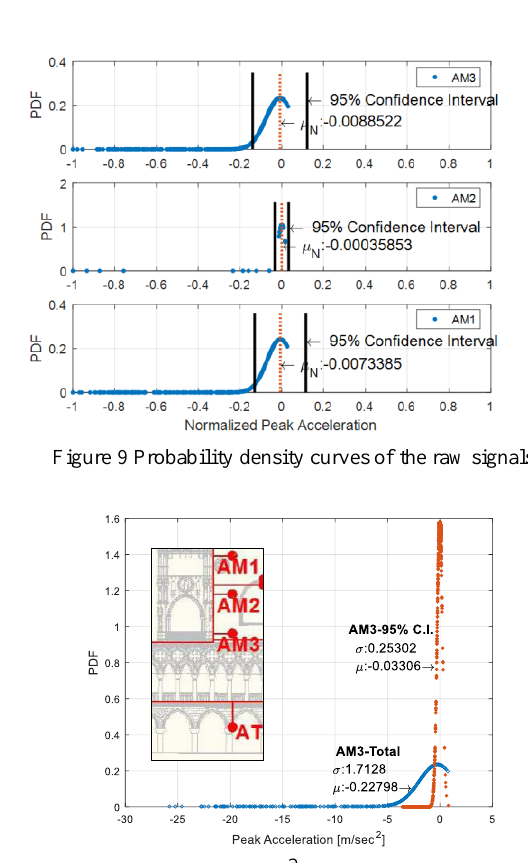
Figure 8. The monthly peak accelerations (bar) and the number of the raw signals collected in 2011 (dashed line)